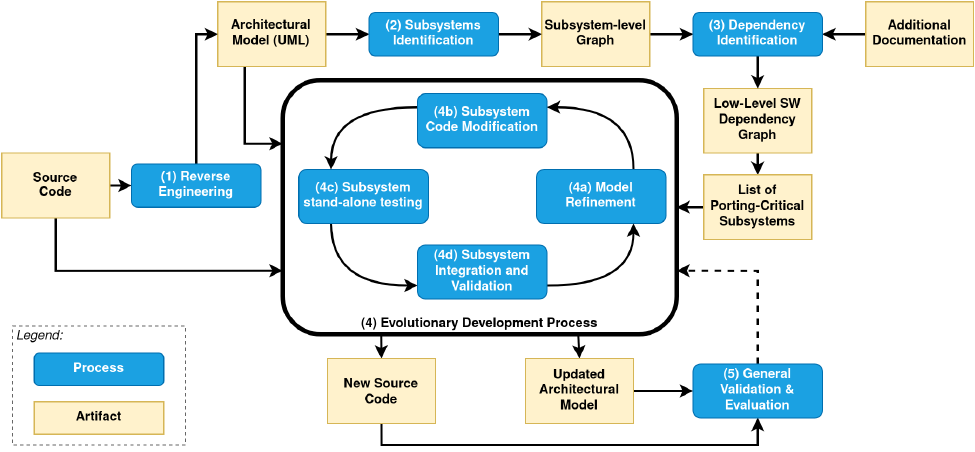
Figure 2. Model-based porting